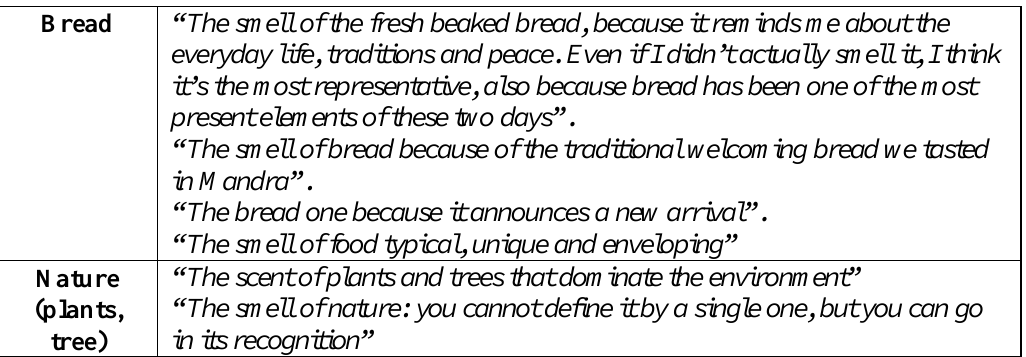
Table 3: Associations made by Italian Participants describing theirs Olfactory Experience